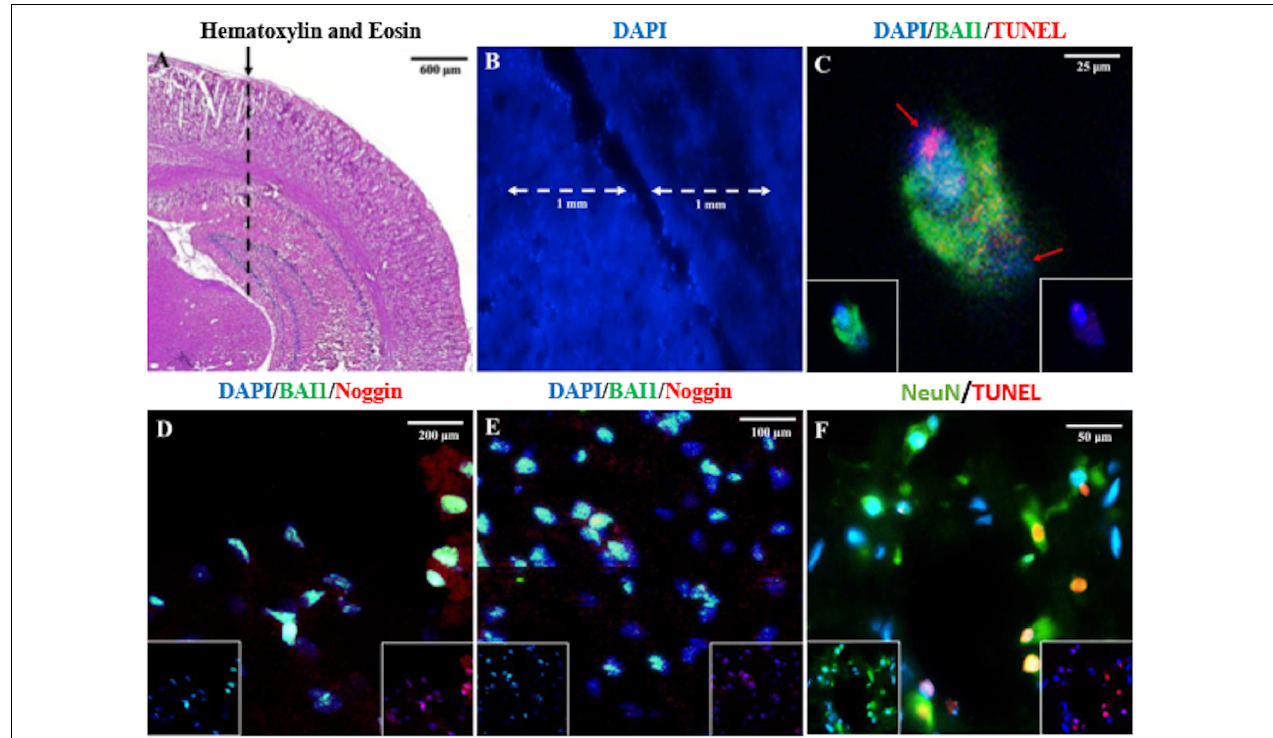
FIGURE 1 | Identification of the NS injury tract lesion site, Myo/Nog cells and dying neurons in the rat brain. The area where the needle is inserted into parietal cortex and hippocampus is shown in the hematoxylin and eosin stained section in (A) (dashed line). The NS tract and the counting area within 1 mm of the lesion is shown in (B) . Sections were double labeled with antibodies to BAI1 (green) and TUNEL reagents (red), BAI1 (green), and Noggin (red) (D,E) , and NeuN (green) (F) and TUNEL (red) (C) . Nuclei were stained with DAPI in (B–F) . Overlap of green and red appear yellow in merged images. Unmerged images are shown as insets at the bottom of the photographs in (C–E) . Images were acquired from the uninjured posterior parietal cortex and hippocampus (A) , along the NS tract within the parietal cortex (B,D) , interface of the parietal cortex and hippocampus (C,F) , and the end of the NS tract in the hippocampus (E) . A BAI1+ Myo/Nog cell appears to have phagocytosed a TUNEL+ cell (C) . The red arrows in (C) depict separate nuclei. Myo/Nog cells co-expressed BAI1 and Noggin (D,E) . The majority of TUNEL+ cells were NeuN+ neurons (F)